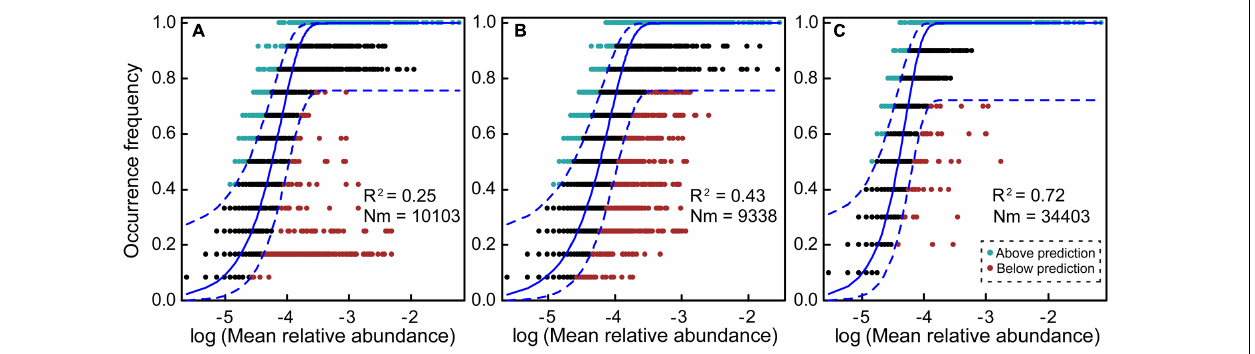
FIGURE 4 | Fit of the neutral model (NM) of community assembly. The predicted occurrence frequencies for plankton and benthos representing microeukaryotic communities from seawater and sediment, respectively. The solid blue lines indicate the best fit to the NM as in Sloan et al. (2006) and dashed blue lines represent 95% confidence intervals around the model prediction. OTUs that occur more or less frequently than predicted by the NM are shown in different colors. Nm indicates metacommunity size times immigration, R 2 indicates the fit to the NM. (A) 12 plankton communities; (B) 12 benthic communities; (C) 10 plankton communities (after removing sites N2 and